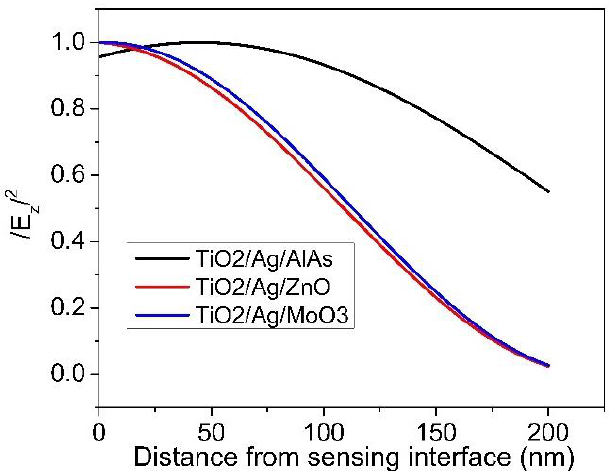
Figure 11. Field profiles for the proposed sensor structures of BK7/TiO 2 (140 nm)/Ag (60 nm)/AlAs (25 nm); prism/TiO 2 (140 nm)/Ag (60 nm)/ZnO (25 nm); and prism/TiO 2 (140 nm)/Ag (60 nm)/MoO 3 (25 nm).